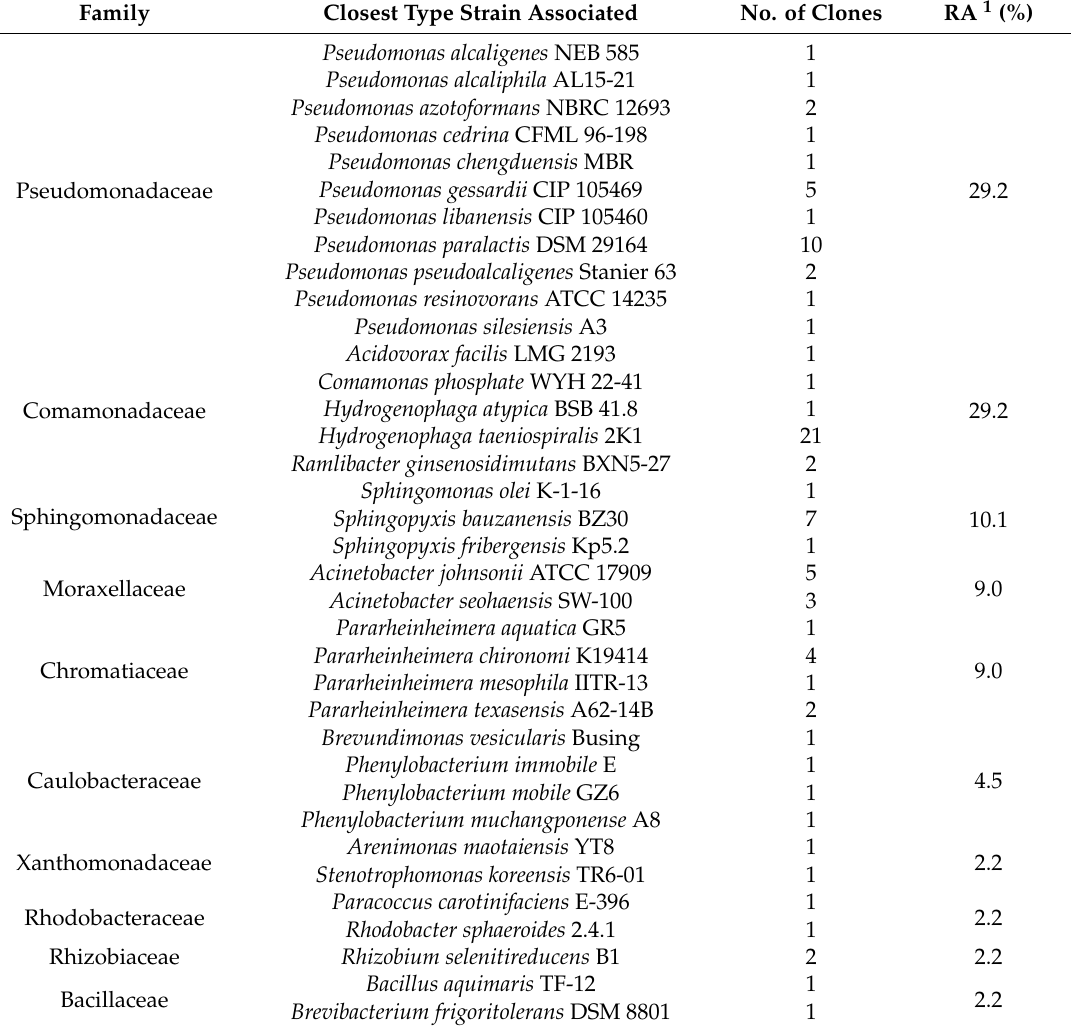
Table 2. Putative classification and relative abundance of bacteria from